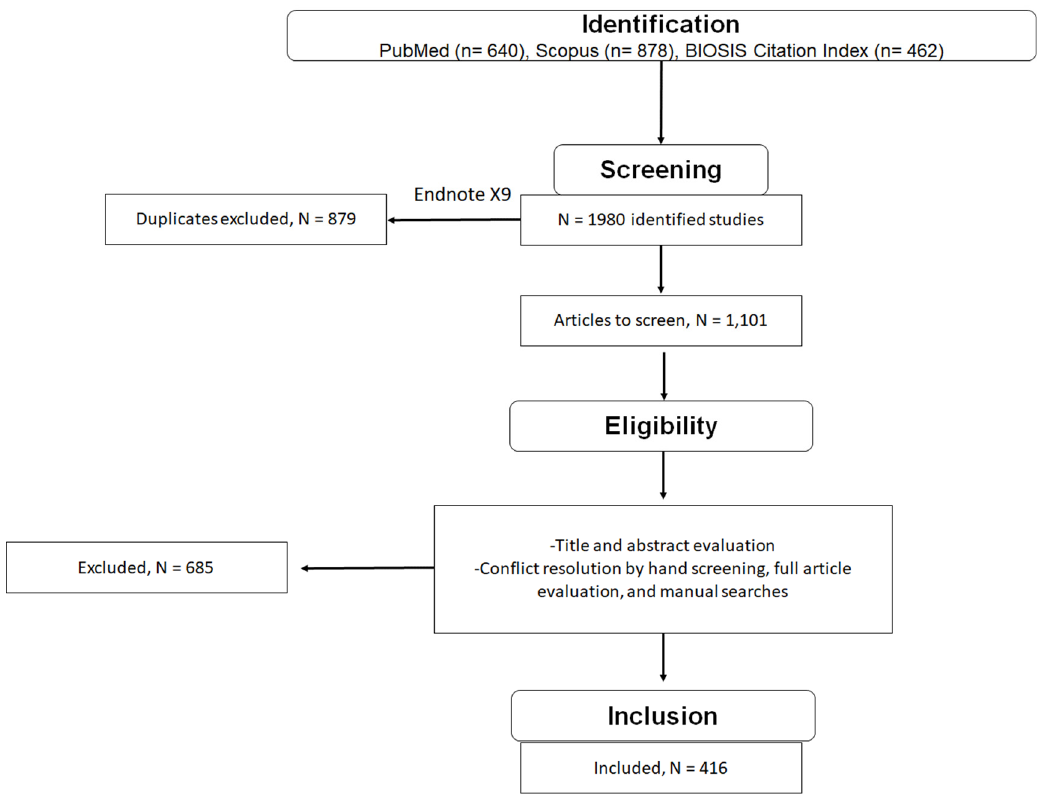
Figure 1. Flow chart depicting the literature screening method.